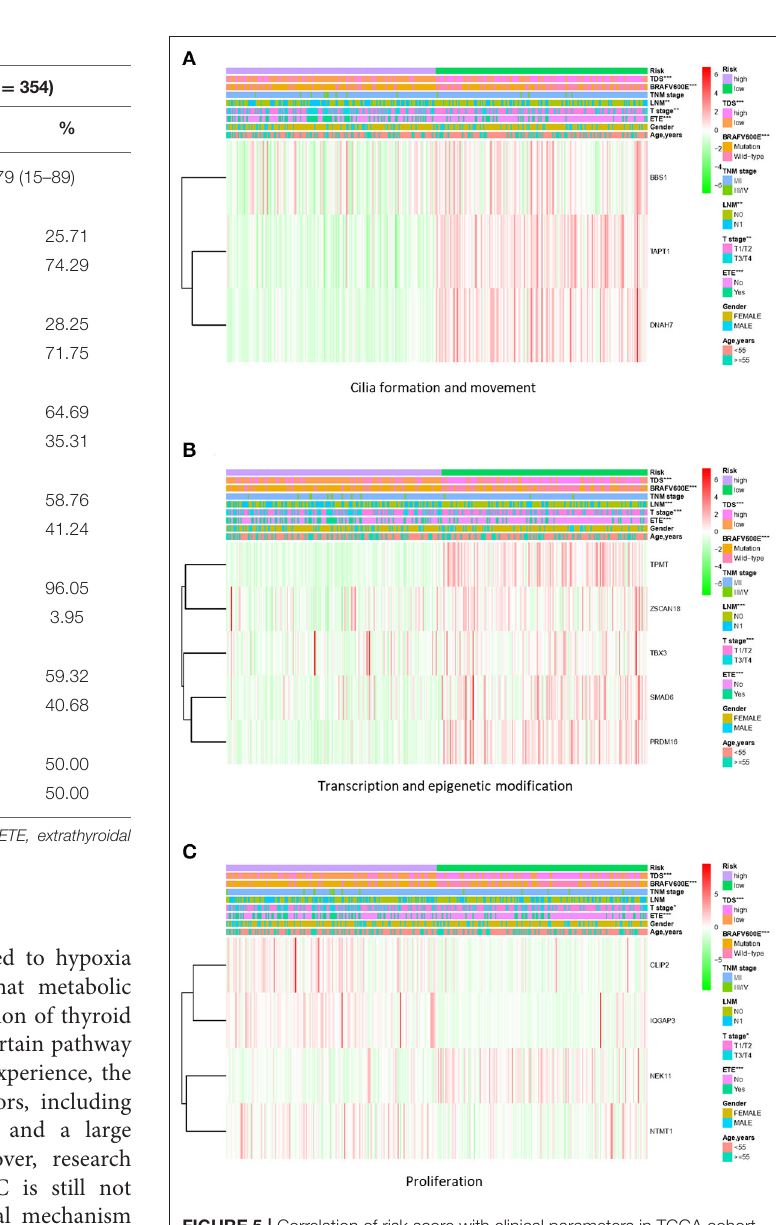
FIGURE 5 | Correlation of risk score with clinical parameters in TCGA cohort. (A) The risk score in cilia formation and movement group was significantly correlated with TDS, BRAF V 600 E mutation, LNM, T stage, and extrathyroidal extension (ETE). (B) The risk score in the transcription and epigenetic modification group was significantly correlated with TDS, BRAF V 600 E mutation, LNM, T stage, and ETE. (C) The risk score in the proliferation group was significantly correlated with TDS, BRAF V 600 E mutation, T stage, and ETE. * p < 0.05, ** p < 0.01, and *** p < 0.001. TCGA, The Cancer Genome Atlas; TDS, thyroid differentiation score; LNM, lymph node